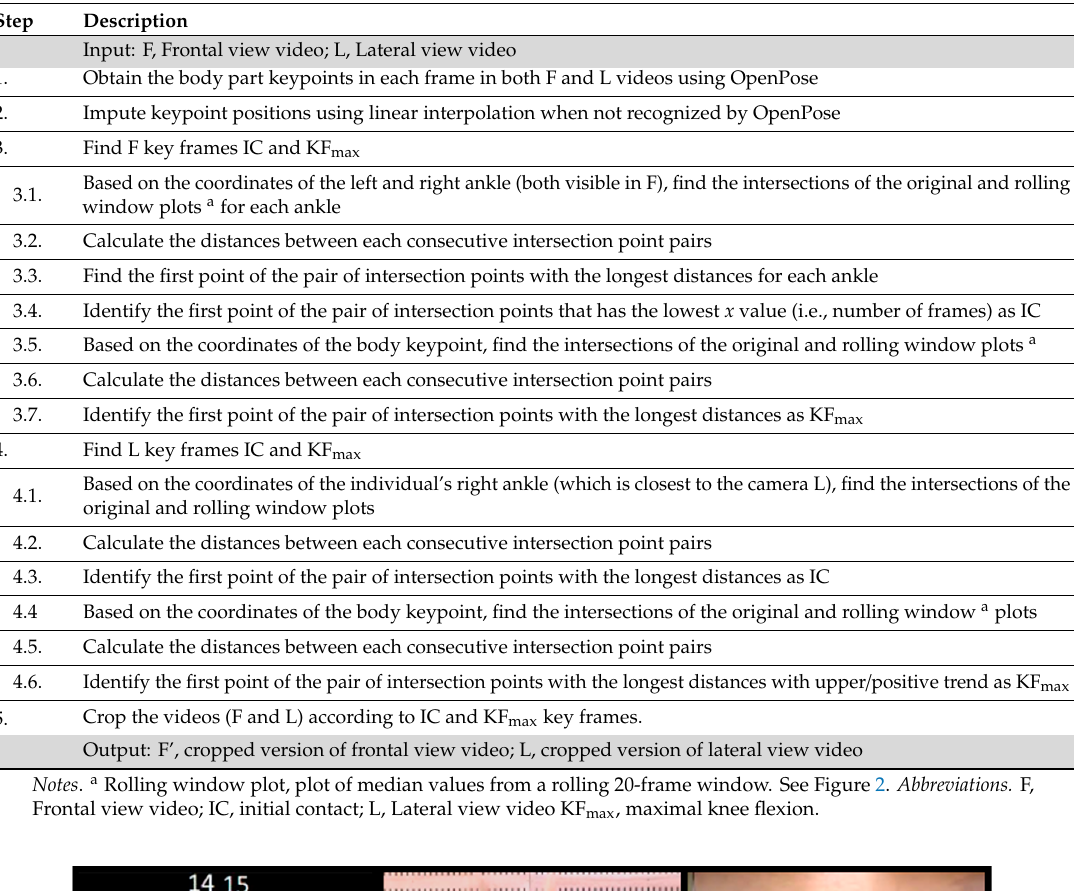
Table 2. Algorithm used to detect key frames from the two input videos.